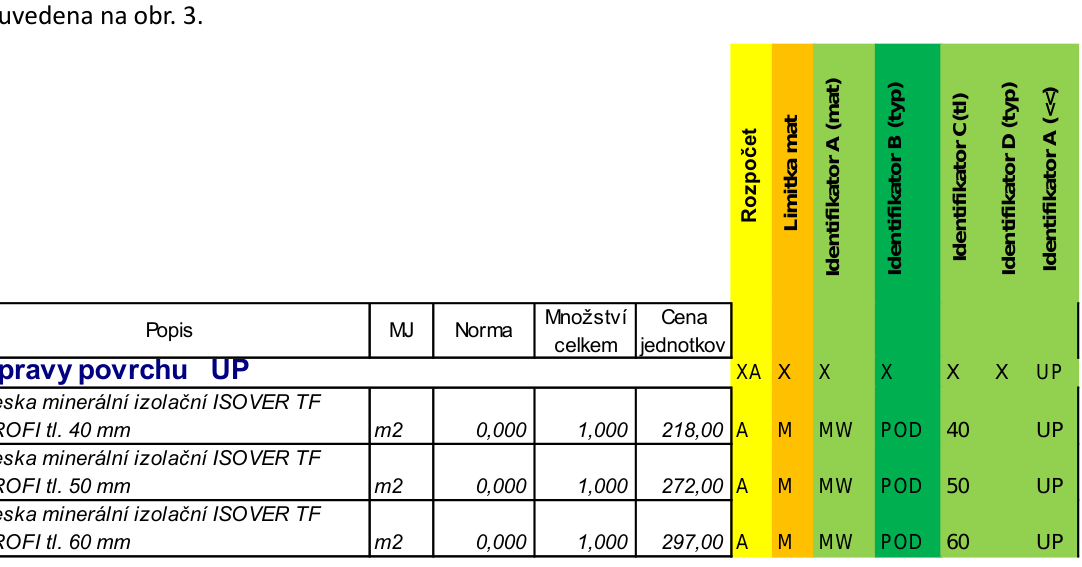
Figure 3: Struktura neveřejné části databáze s identifikátory položek (zdroj: autor) V rámci aplikace sestavené v nadstavbě tabulkového procesoru VBA [10] jsou navrženy